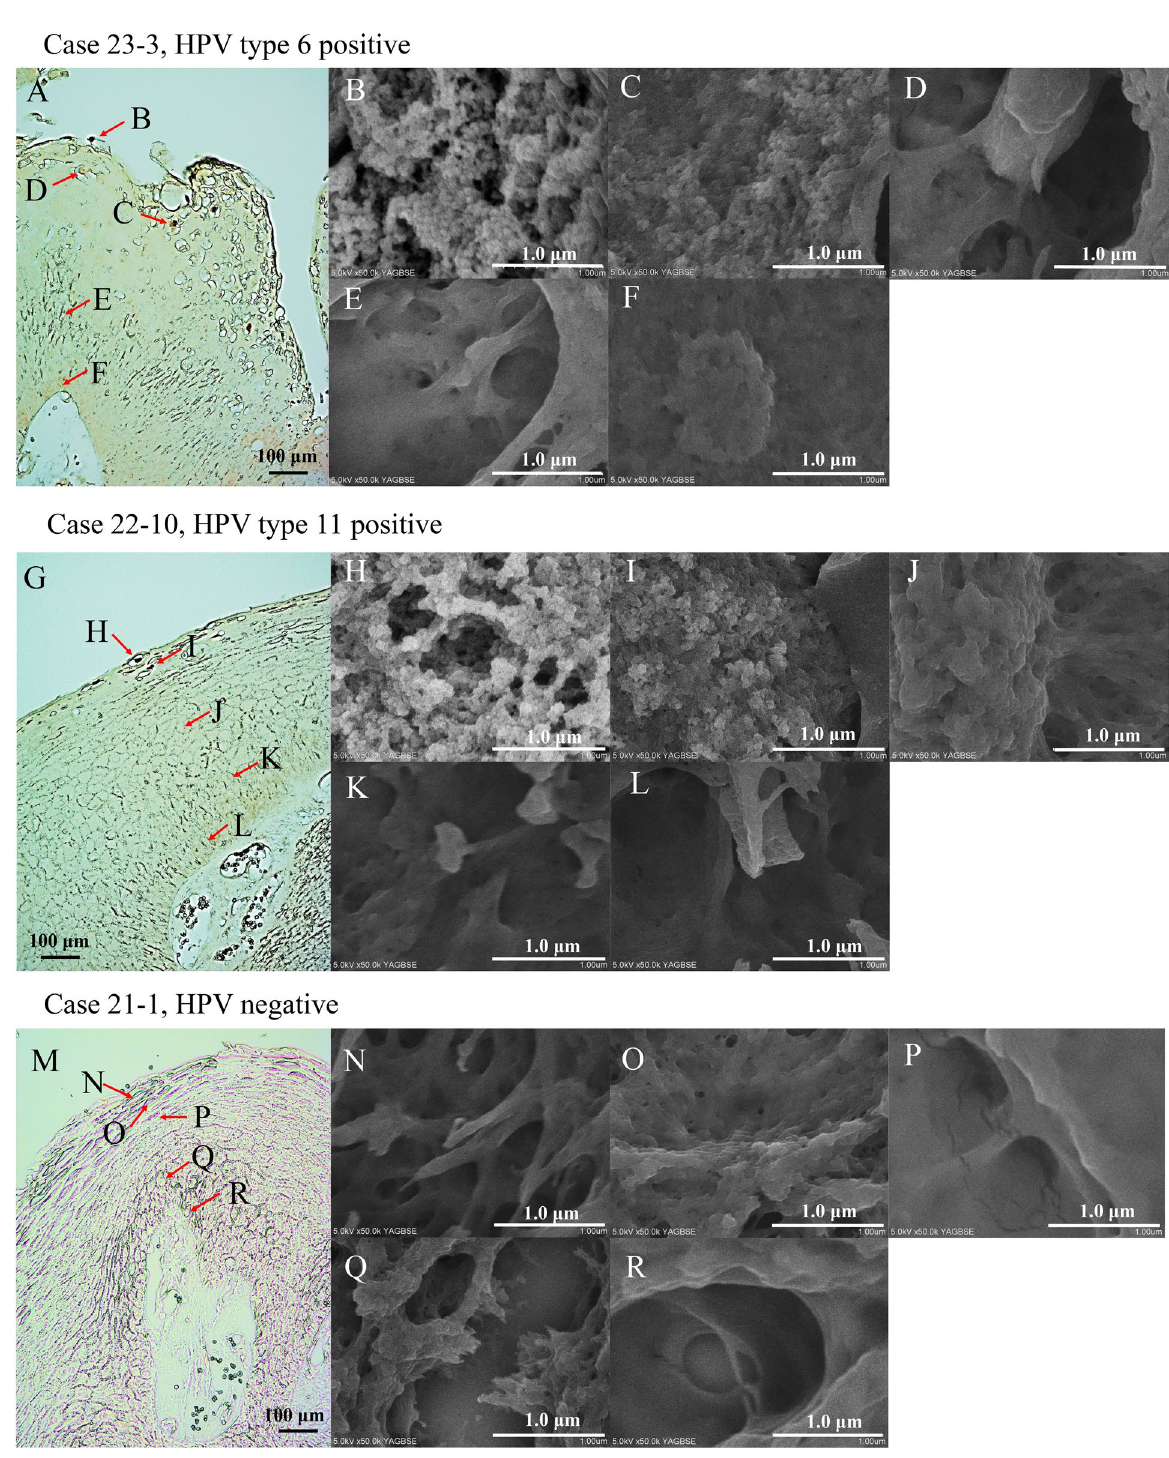
Figure 4. HPV particle formation process. ( A – F ) The process of particle formation in the HPV type 6 case. HPV L1 IHC is performed, and the arrows indicate the observation object. A 200 × field of view is observed. The bar indicates 100 μm ( A ). In areas where HPV L1 IHC is strongly stained ( B ), numerous HPV particles are observed, whereas in areas where HPV L1 IHC is weakly stained ( C ), the number of HPV particles is reduced, and some particles appear to be immature. Areas where HPV L1 IHC-negative lesions show no HPV particles ( D – F ). At 50,000 × field of view, the white bar indicates 1.0 μm ( B – F ). ( G – L ) The process of particle formation in HPV type 11 cases. HPV L1 IHC is performed, and the arrows indicate the observed object. A 200 × field of view is observed. The black bar indicates 100 μm ( G ). In areas where HPV L1 IHC is strongly stained ( H ), numerous HPV particles are observed, whereas in areas where L1 is weakly stained ( I ), the number of HPV particles is reduced, and some particles appear to be immature. Areas where HPV L1 IHC-negative lesions show no HPV particles (J–L). At 50,000 × field of view, the white bar indicates 1.0 μm ( H – L ). ( M – R ) HPV-negative case. HPV L1 IHC is performed, and the arrows indicate the observed object. A 200 × field of view is observed. The black bar indicates 100 μm ( M ). No HPV particles are observed (N–R). At 50,000 × field of view, the white bar indicates 1.0 μm ( N – R ). HPV Human papillomavirus, IHC